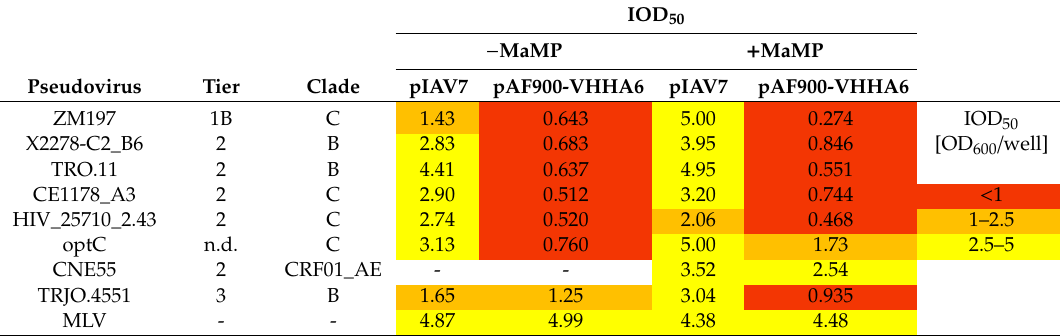
Table 1. Neutralization of HIV-1 by lactobacilli with surface-anchored VHHA6 ( L. rhamnosus . pAF900-VHHA6) in the infectivity depletion assay. Pseudovirus Tier